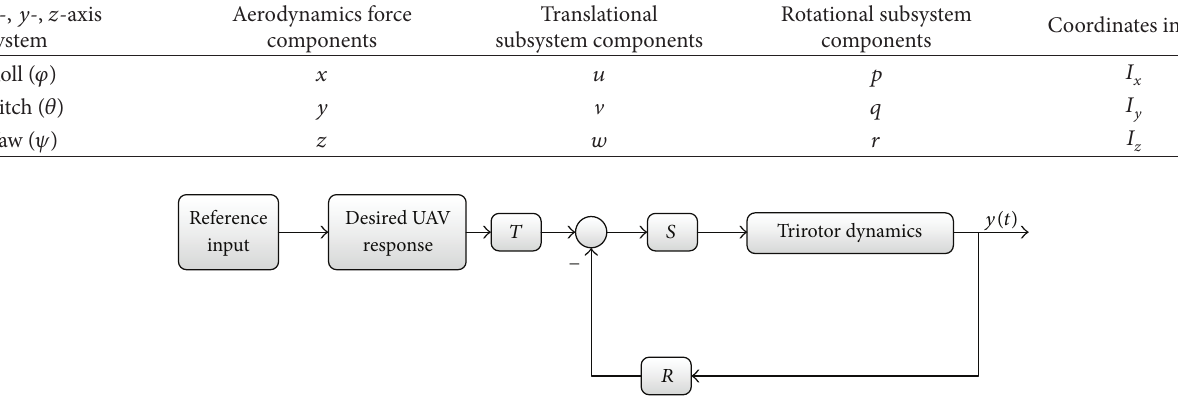
Figure 6: Internal close-loop block diagram of RST controller.